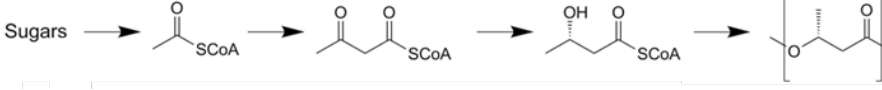
Figure 2. Biological synthesis scheme of P3HB.